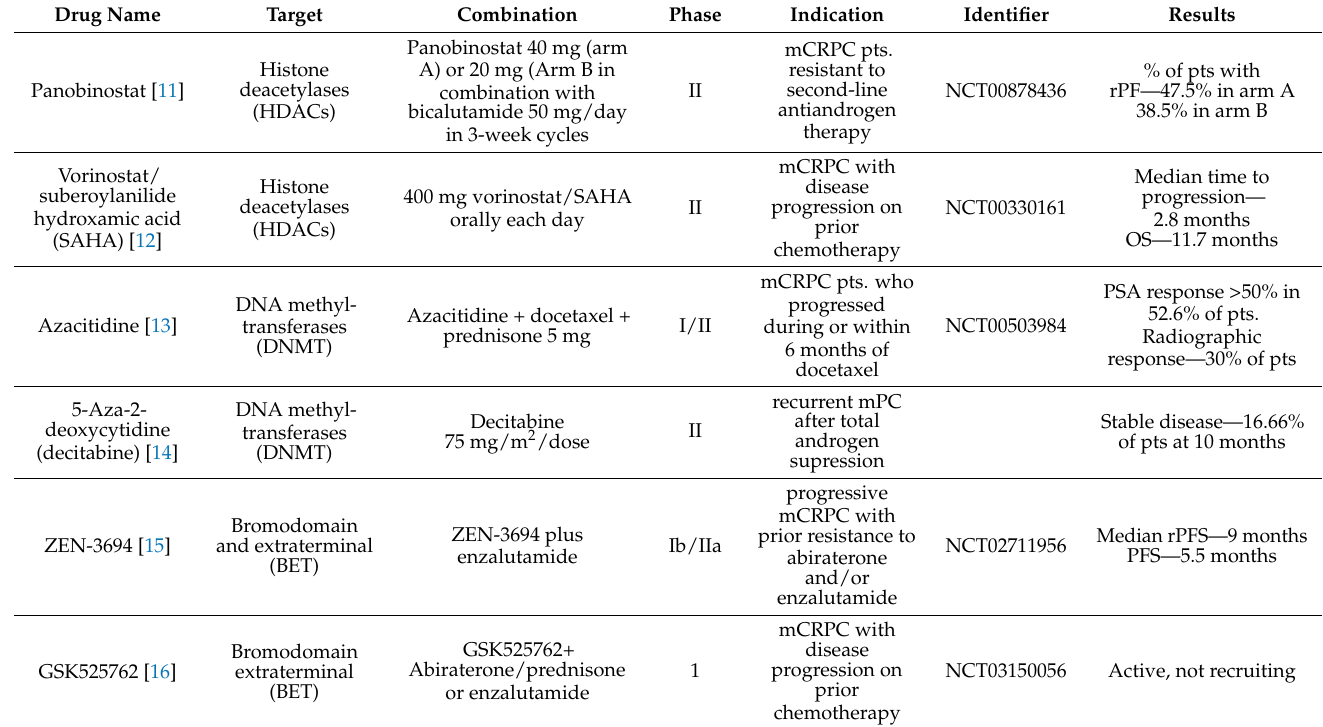
Table 1. Results of epigenetic drugs in clinical trials for prostate cancer. (mCRPC—metastastic castrate- resistant prostate cancer, rPF—radiographic progression-free, OS—Overall survival, mPC—metastatic prostate cancer, PFS—progression-free